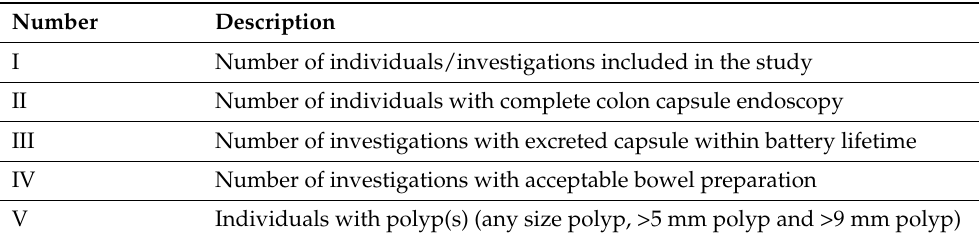
Table 1. Data extracted for statistical